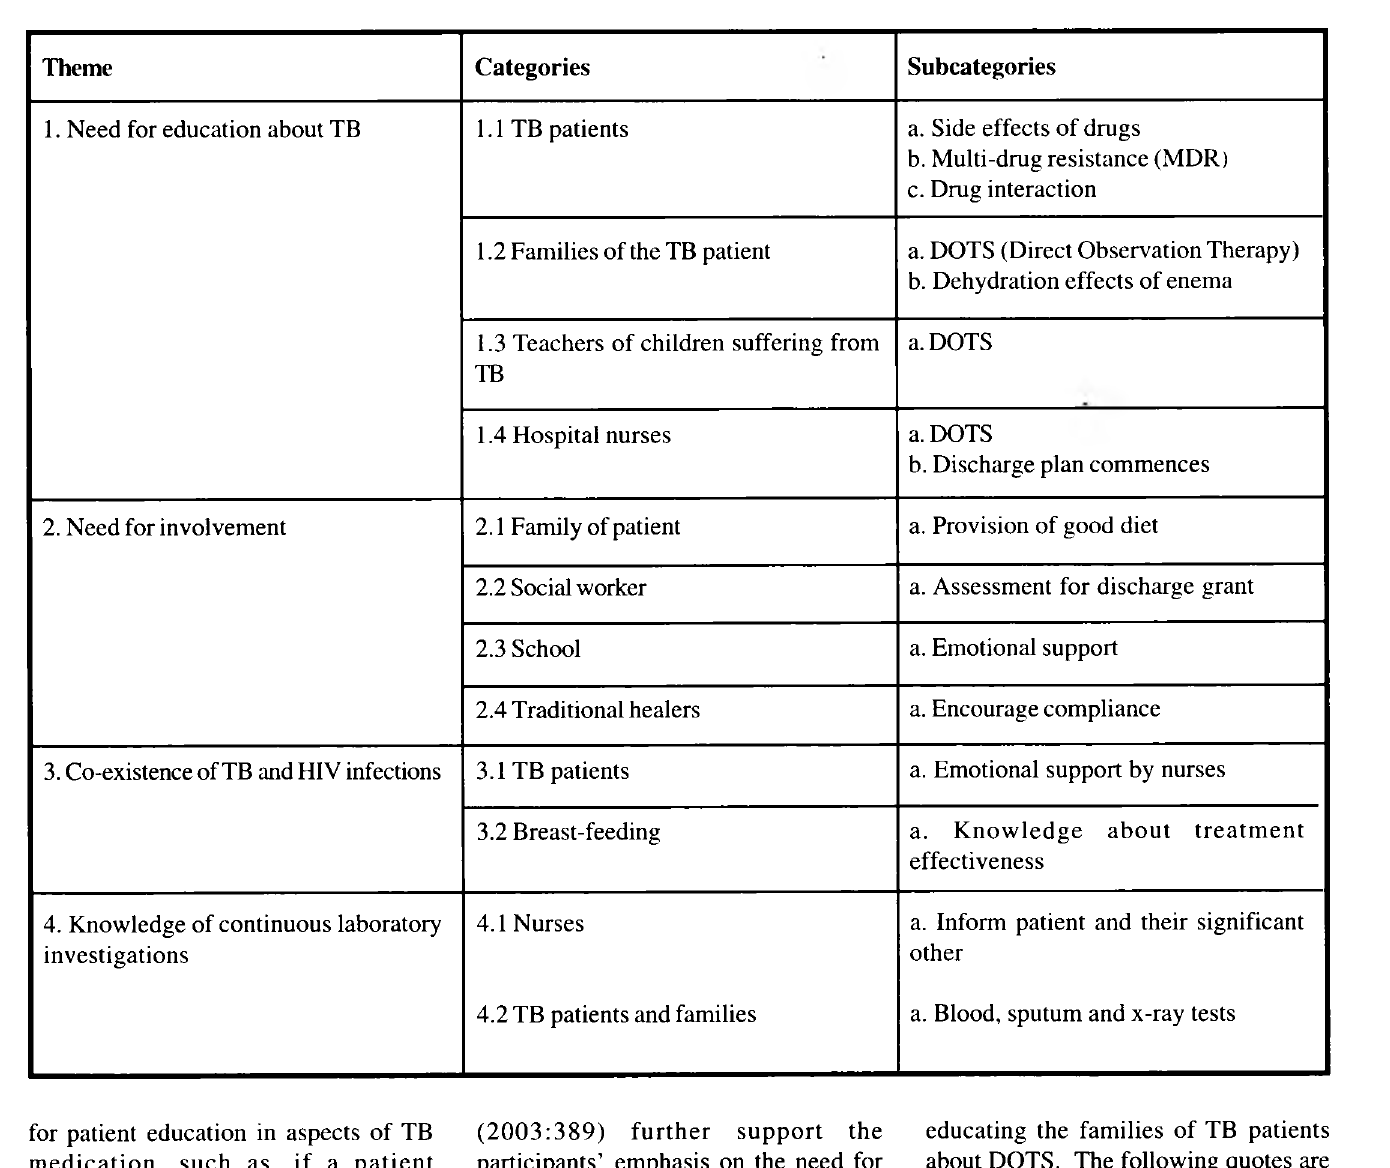
Table 1: Summary of themes, categories and subcategories